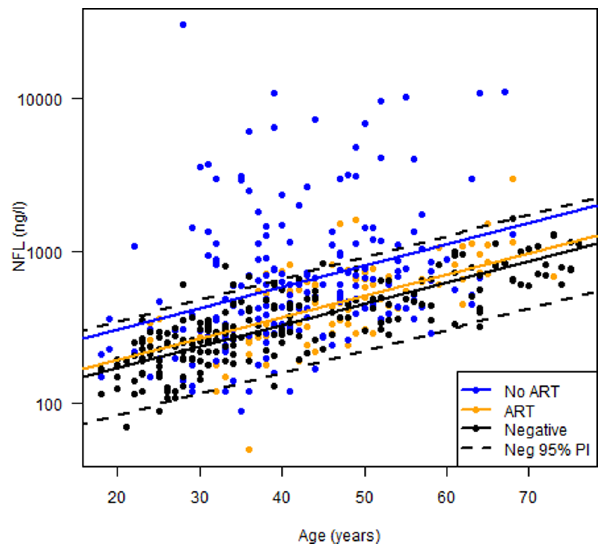
Figure 3. CSF NFL related to age and treatment effect. Since CSF NFL increases with age, we analyzed the group differences with a linear mixed effects model with age as covariate. This implies a model with three parallel regression lines where the group differences correspond to the vertical distances between the regression lines. The group differences can be expressed as the corresponding age increase needed for an equivalent difference. The 95% prediction interval of CSF NFL levels of HIV-negative controls is demonstrated as dotted lines (Neg 95% PI). Concentrations of CSF NFL in neuroasymptomatic untreated HIV-infected subjects (No ART) were equivalent to those of HIV-negative subjects (negative) who were 18.5 years older (p , 0.001). CSF NFL concentrations in the treated group (ART) were equivalent to those of HIV-negative subjects who were 3.9 years older (p , 0.01).